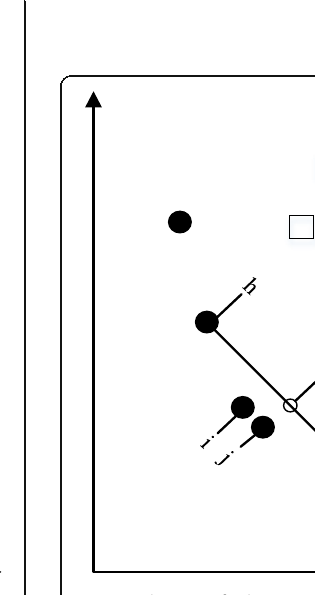
Fig. 4 Population distribution problem Fig. 5 Selection of adjacent excellent